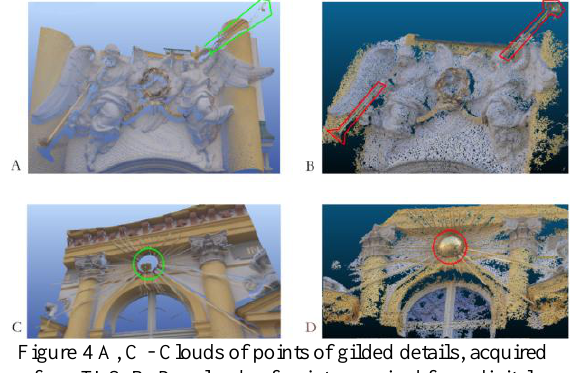
Figure 4 A, C - Clouds of points of gilded details, acquired from TLS. B, D - clouds of points acquired from digital image matching (red - blind spots, green - geometric corrections). Figure 5 Cloud of points: I . ornamental fabrics: I.A orthogonal projection, parallel to the plane (TLS), I.B- orthogonal projection, perpendicular to the plane (TLS), I.C orthogonal projection, parallel to the plane (Matching), I.D- orthogonal projection, perpendicular to the plane (Matching); II . Plaster: II.A axonometric projection (TLS), II.B- axonometric projection (Matching)